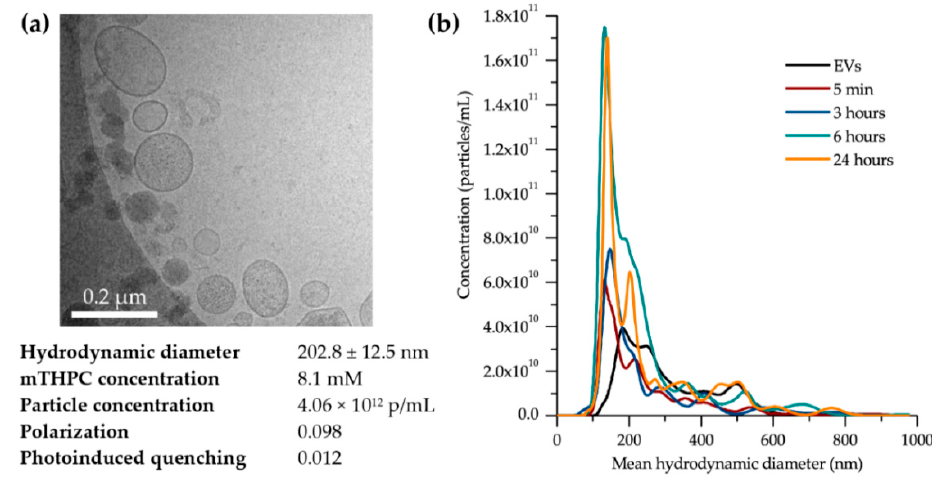
Figure 1. Characteristics of meta-tetra(hydroxyphenyl)chlorin–extracellular vesicles (mTHPC-EVs). ( a ) Morphology of mTHPC-EVs determined by cryo-transmission electronic microscopy (TEM); below the scan, the NanoSight photophysical properties of mTHPC-EVs along with the physico-chemical and photophysical characteristics of mTHPC-EVs. ( b ) Incubation kinetics of mTHPC-EVs in the presence of 20% exo-free murine plasma determined by NanoSight.